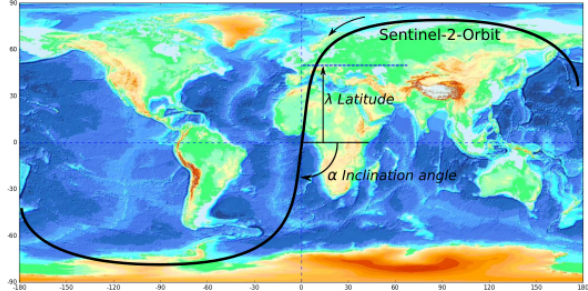
Figure 6. Orbit of Sentinel-2 on day-side from north to south, descending node with Inclination angle α = − 98 . 62